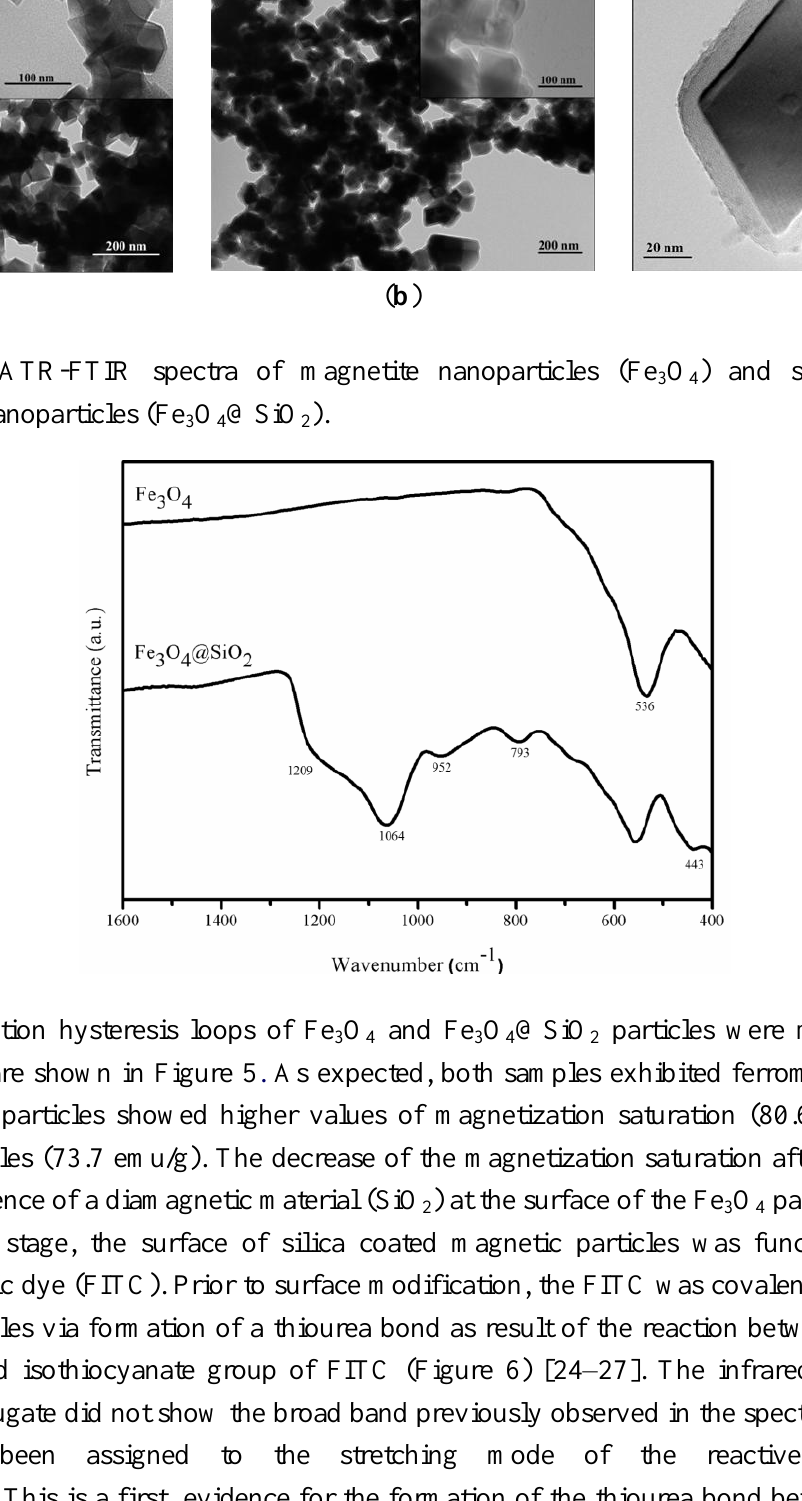
O ) and silica coated 3 4